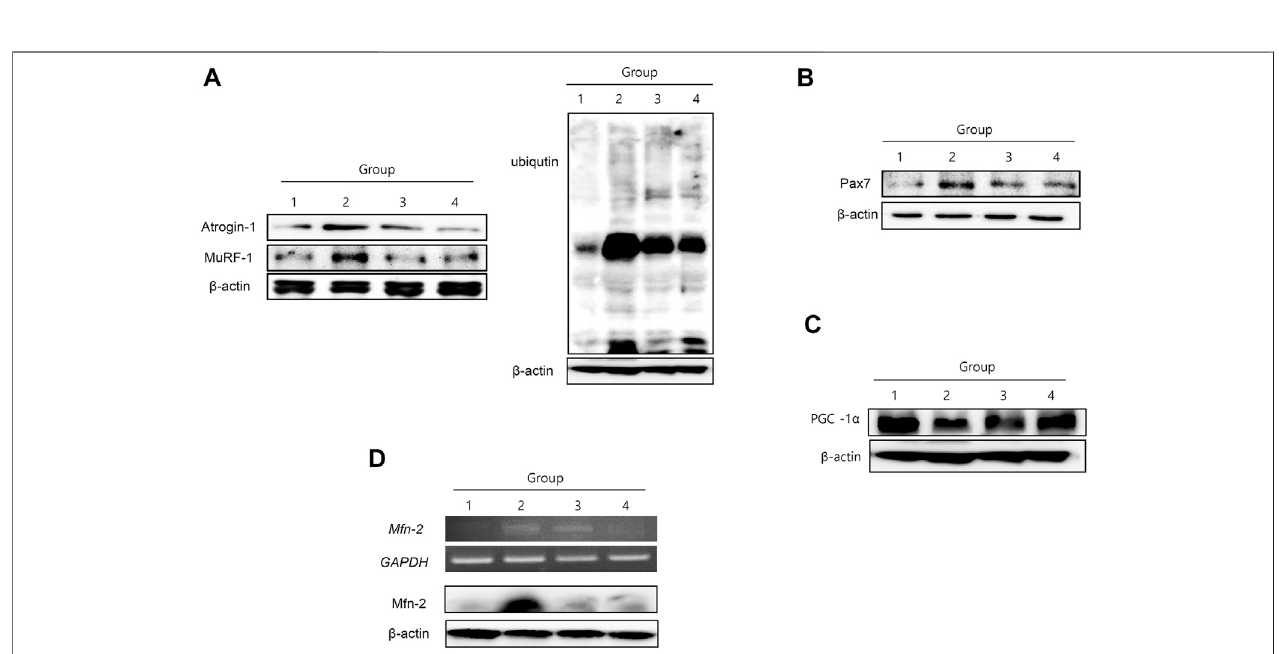
FIGURE4| Changesofmuscle-speci fi cUPSligaseatrogin-1andMuRF-1,Pax7,PCG-1 α ,andmitofucin-2. (A) Westernblotforatrogin-1andMuRF-1according tothegroups (I) andUPSligaseaccordingtothegroupsblottedwithligase (II) . (B) WesternblotforPax7and (C) WesternblotforPCG-1 α (D) RT-PCRandWesternblot for